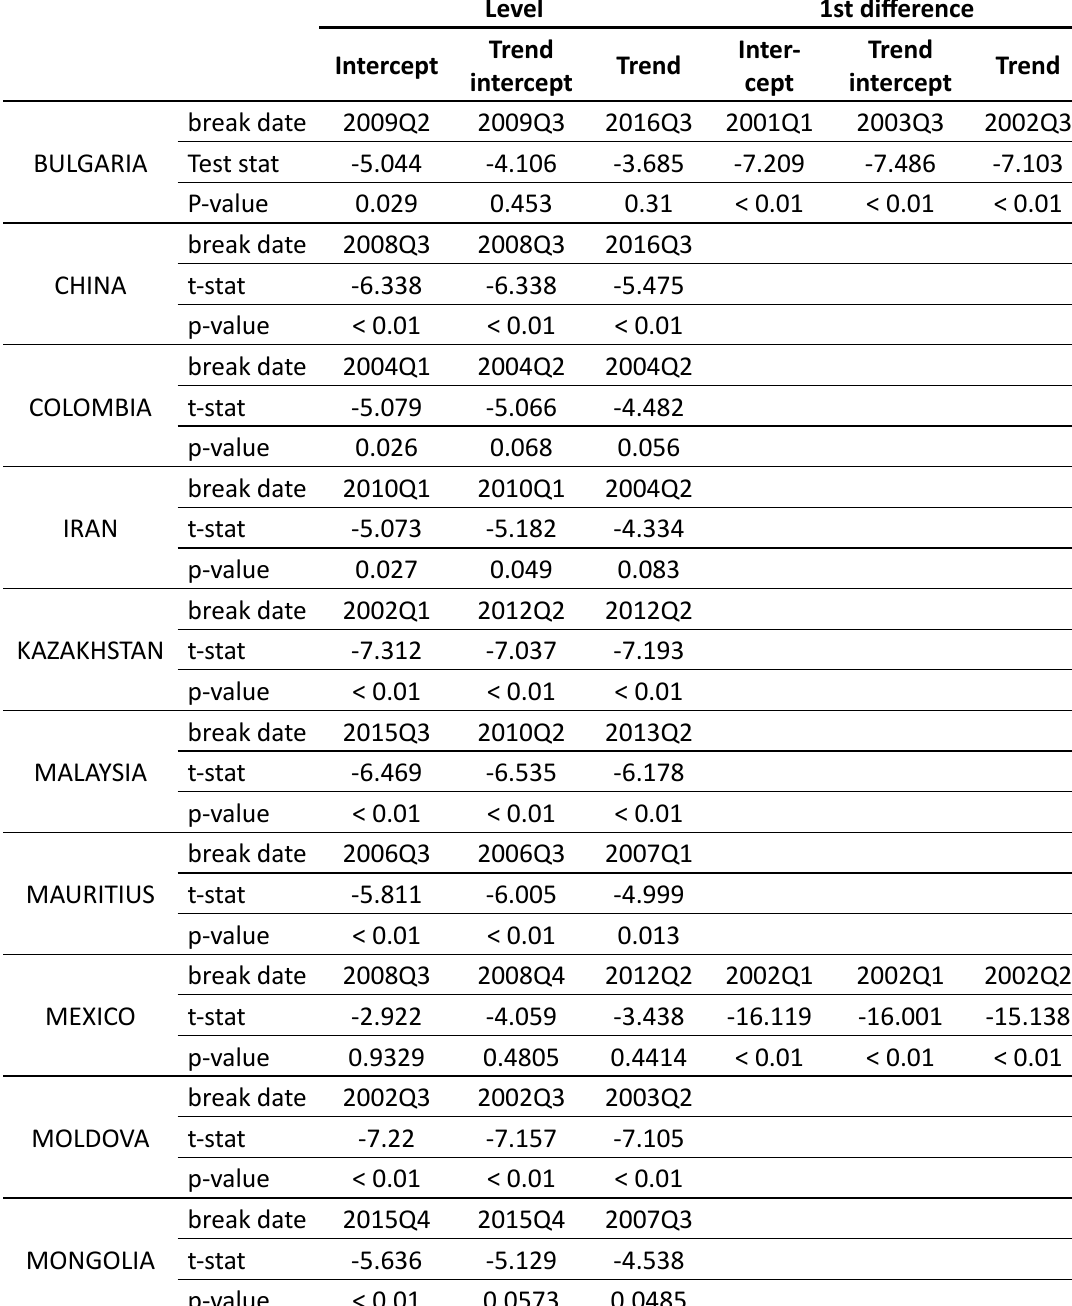
Table 2: Breakpoint ADF Unit Root Test Level 1st difference Trend Intercept Trend intercept